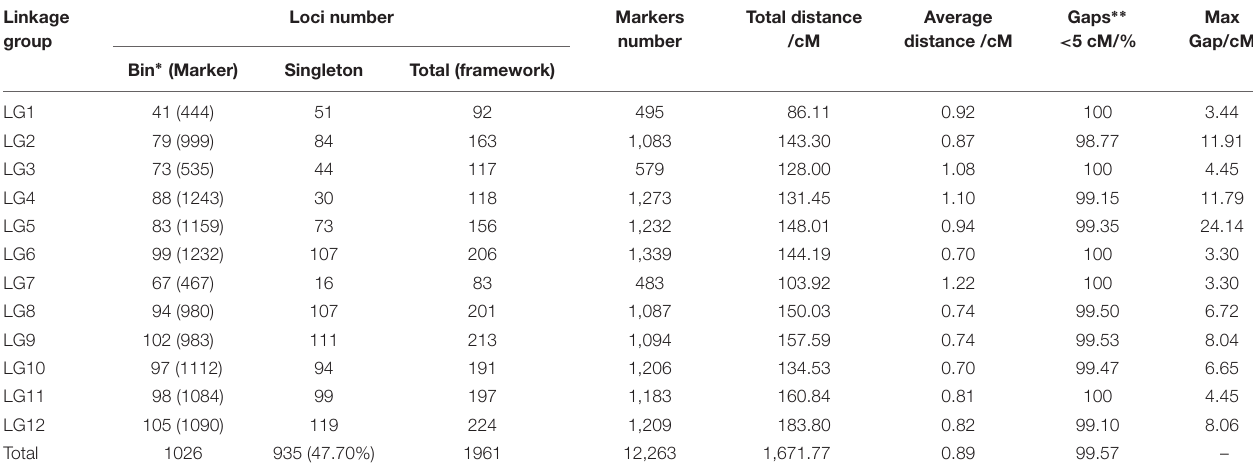
TABLE 3 | Characteristics of the 12 linkage groups of G. biloba . Linkage group